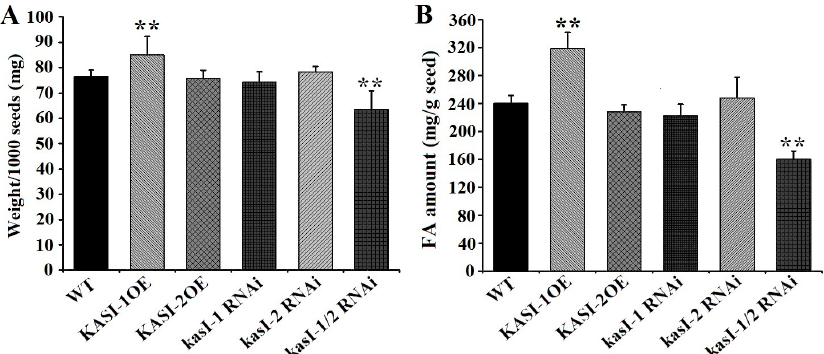
Figure 9. Seed weight and lipid content in tobacco: ( A ) thousand-seed weights in WT and all transgenic lines; and ( B ) the lipid contents in WT and all transgenic lines. Error bars represent the standard errors with four biological replications. The asterisk above the bars indicates the significant differences between transgenic plants and WT (** p < 0.01).